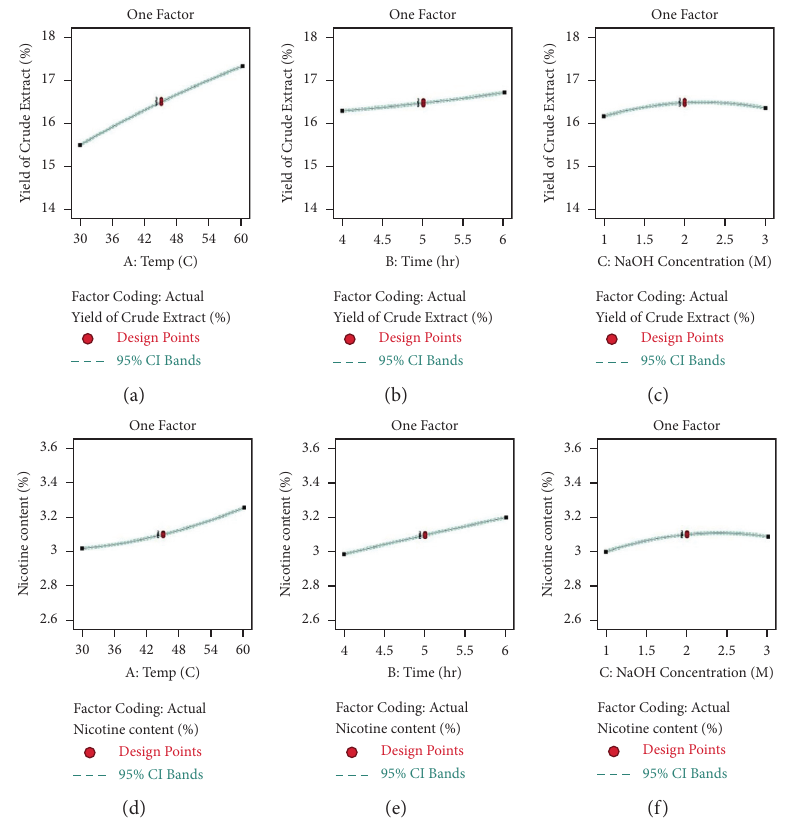
Figure 5: (a), (b), (c) Effect of temperature, time of extraction, and NaOH concentration on yield of extract. (d), (e), (f) Effect of temperature, time of extraction, and NaOH concentration on nicotine